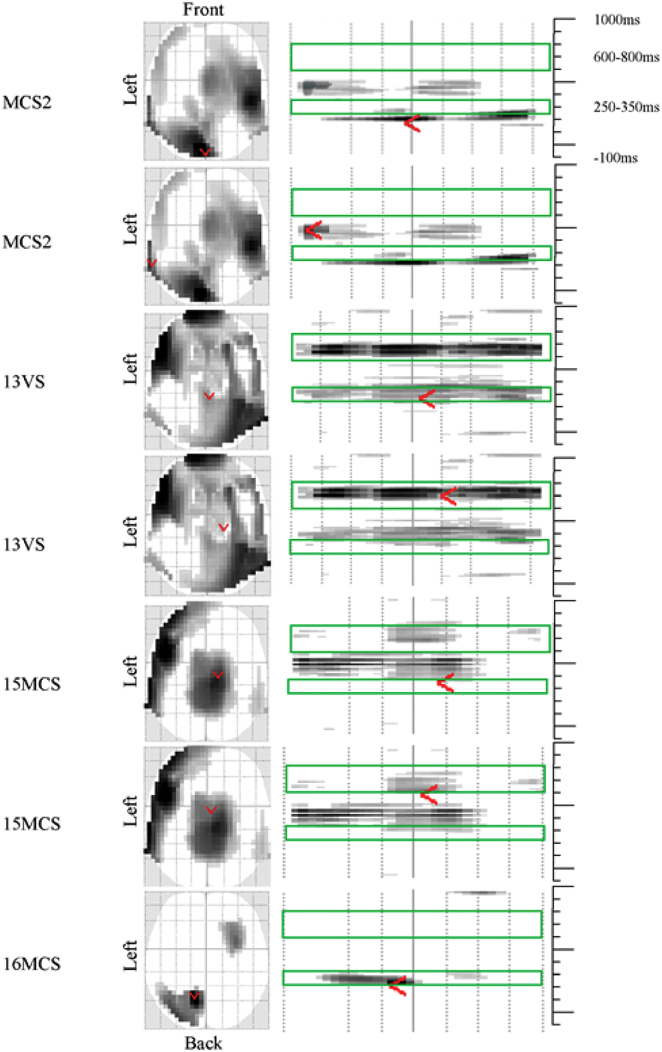
Results of F test difference between responses to own name and other names within the window of −100 ms to 1000 ms. Early (250–350 ms) response and late (600 − 800 ms) response in four pDOC patients showing the F test results with the statistical significant differences between responses to own name vs. responses to other names. The red arrow indicates the most significant response indicating the spatial position of the most significant responses. VS/UWS- Vegetative State/Unresponsive Wakefulness Stata, MCS- Minimally Conscious State.